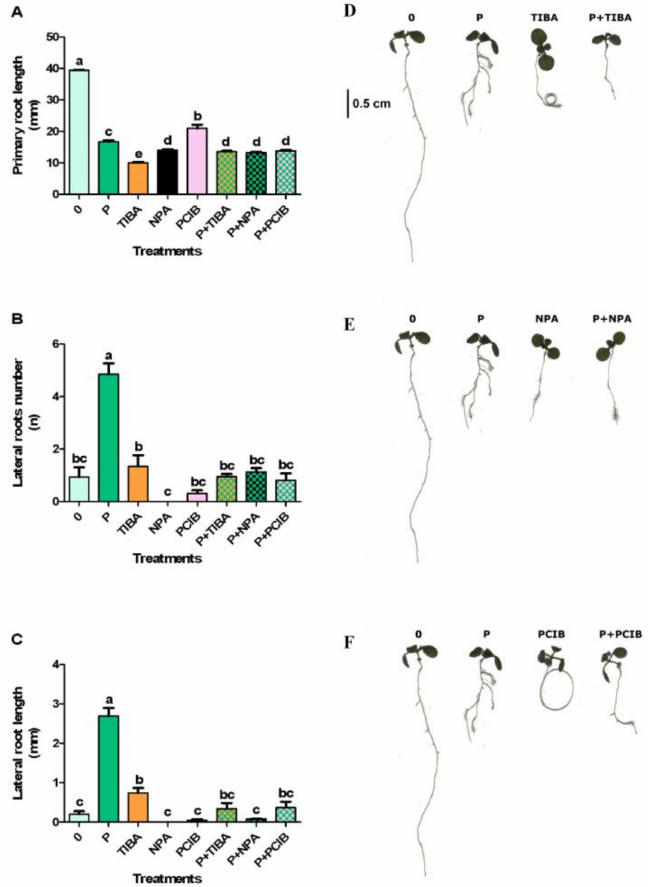
Figure 4. Primary root length ( A , D ), lateral roots number ( B , E ), and lateral root length ( C , F ) of A. thaliana seedlings treated with protodioscin (P), alone or in combination with auxin inhibitors TIBA, NPA, and PCIB (averaged data on the left side and representative image on the right side). Different letters indicate significant differences observed among treatments at p ≤ 0.05 (SNK’s test). N =